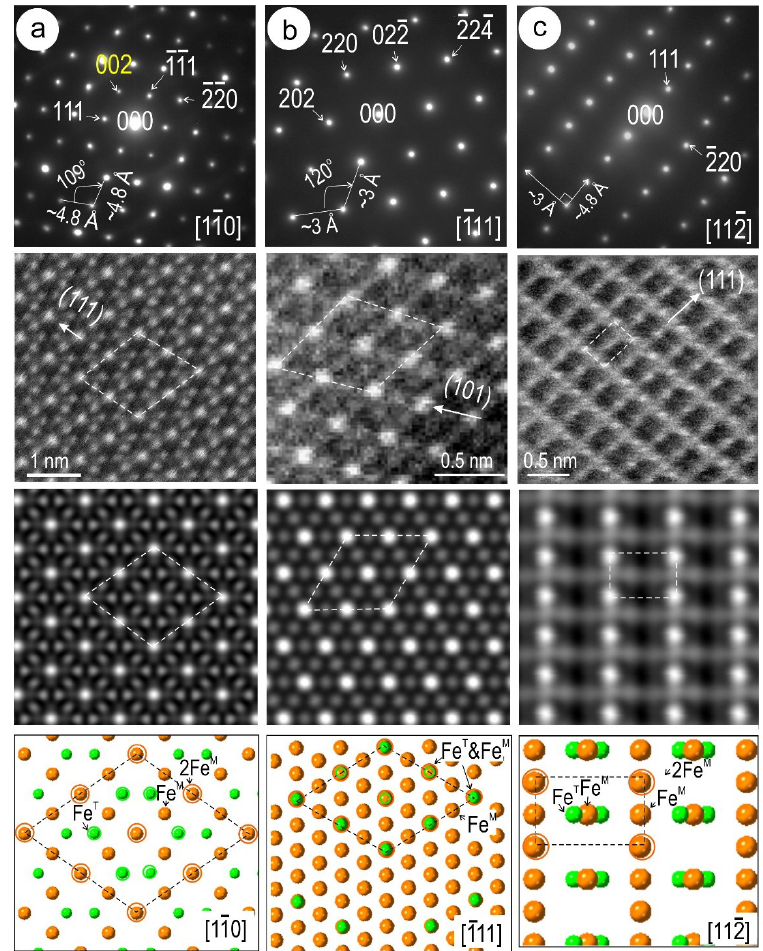
Figure 18. Assessment of HAADF STEM images for magnetite on three main zone axes as marked. Each zone axis is illustrated along the a to c columns representing, from top to bottom: SAED, HAADF image, STEM simulation and crystal model. The presence of forbidden (002) reflections for space group Fd 3 m , albeit weaker than (004), is observed on SAEDs for [110] zone axis (yellow; a). Such reflections cannot be attributed to double diffraction since they are also present on the FFTs obtained from HAADF STEM images but could be associated with lower symmetry, for example, space group 43 instead of Fd 3 m (Table 1; [3]). Images of magnetite on both [110] and [111] zone axes display a rhomb-shaped motif with brighter atoms surrounded by 10 and 6 less brighter atoms, respectively ( a , b ). The image for [112] zone axis shows brighter atoms at the corner of a rectangular pattern and also the presence of less bright atoms forming a rectangular subset at half-distance to the main pattern ( c ). The corresponding crystal structure models show that the bright atoms coincide with positions of higher density atoms along the direction of view, corresponding, in magnetite, to an overlap between two Fe atoms with either the same coordination, or with both types of coordination, tetrahedral (T) and rhombohedral (M). STEM simulation for the [110] image, however, requires a setting of the Fd 3 m cell with atom coordinates at origin 1 as given by Yamanaka et al. [16] rather than origin 2, the conventional setting for magnetite and other “2-3”-type spinels (Table 1). Simulation using the 43 space group of lower symmetry does not give such a good fit as Fd 3 m cell with atom coordinates at origin 1.